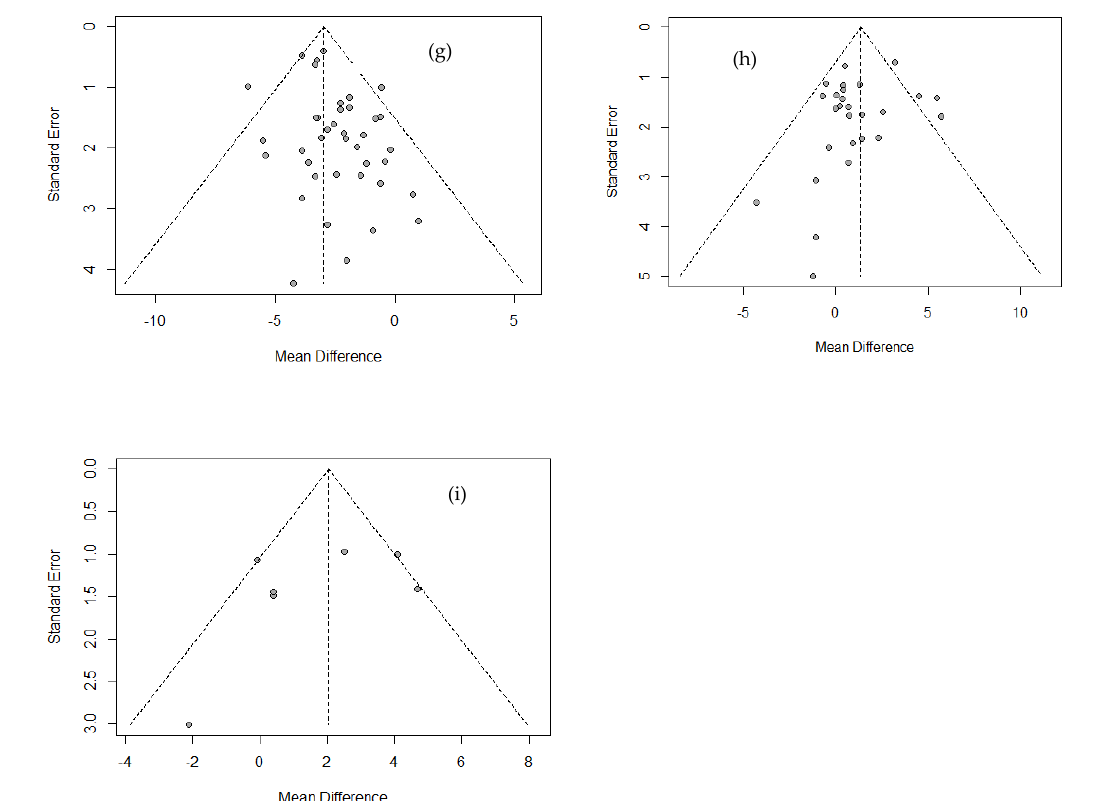
Figure 4. Funnel plot showing the publication bias of Physique and body composition. ( a ) Height; ( b ) weight; ( c ) BMI; ( d ) WC; ( e ) WHR; ( f ) fat mass.; ( g ) % body fat; ( h ) lean mass; ( i ) muscle mass.